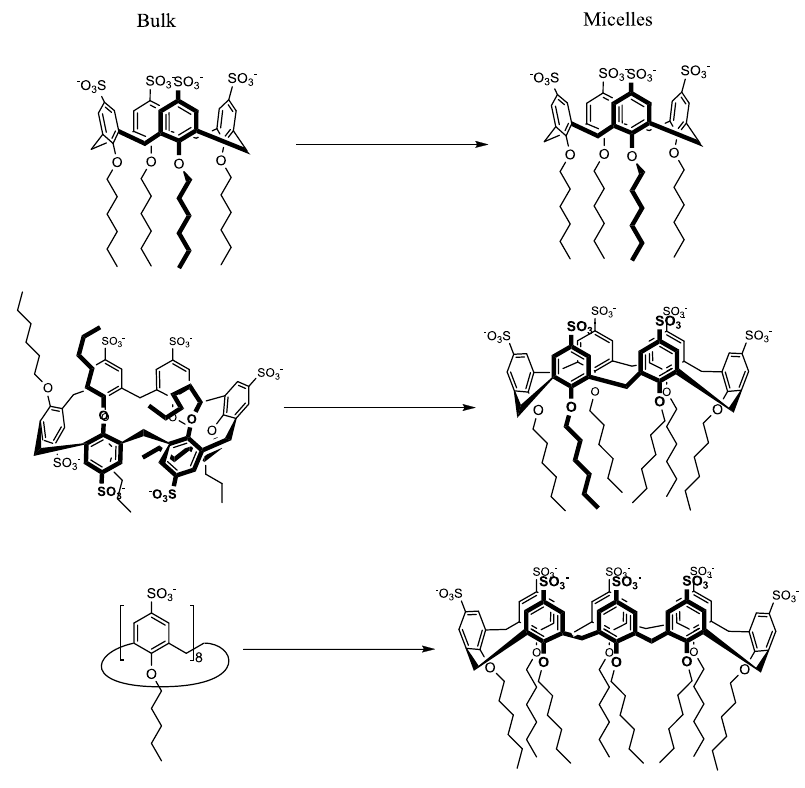
Figure 6. Conformational reorganization of amphiphilic p -sulfonatocalix[ n ]arenes upon